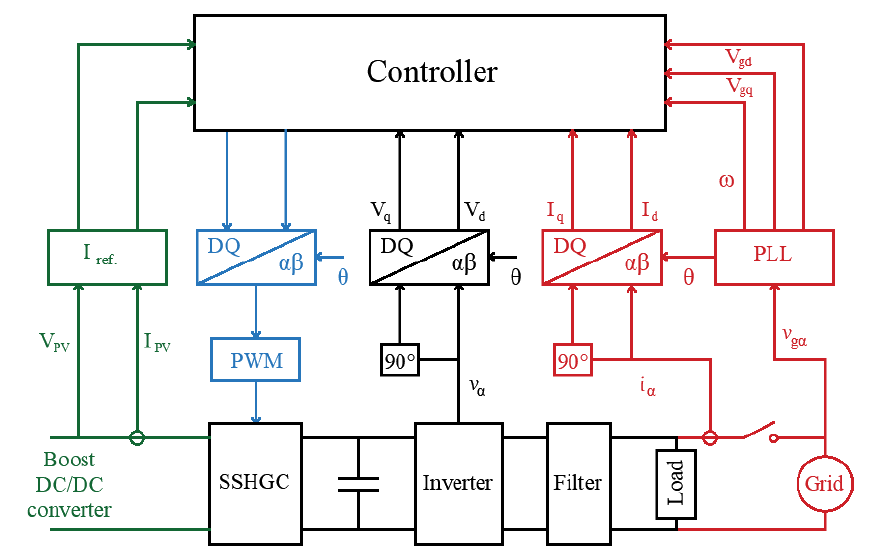
Figure 14. The block diagram of the 5H inverter controller.